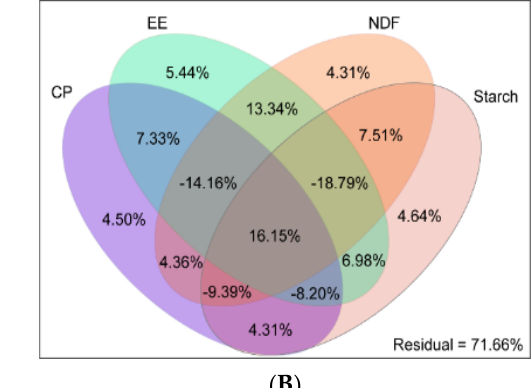
Figure 2. ( A ) Histogram of the LDA scores computed for differentially abundant rumen bacteria across the different ages of dairy cattle. Significant differences are defined as p < 0.05 and LDA score >4.0. ( B ) The LDA effect size (LEfSe) analysis of bacterial taxa within the different ages of dairy cattle. Cladogram shows significantly enriched bacterial taxa (from phylum to genus level).